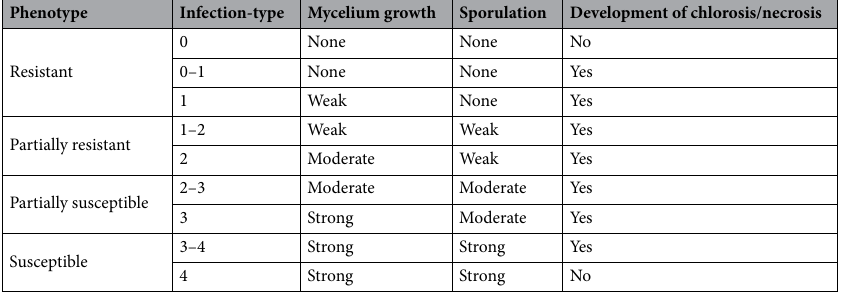
Table 3. Nine-step 0–4 scale for scoring infection types in cereal powdery mildew, after Torp et al. 88 .